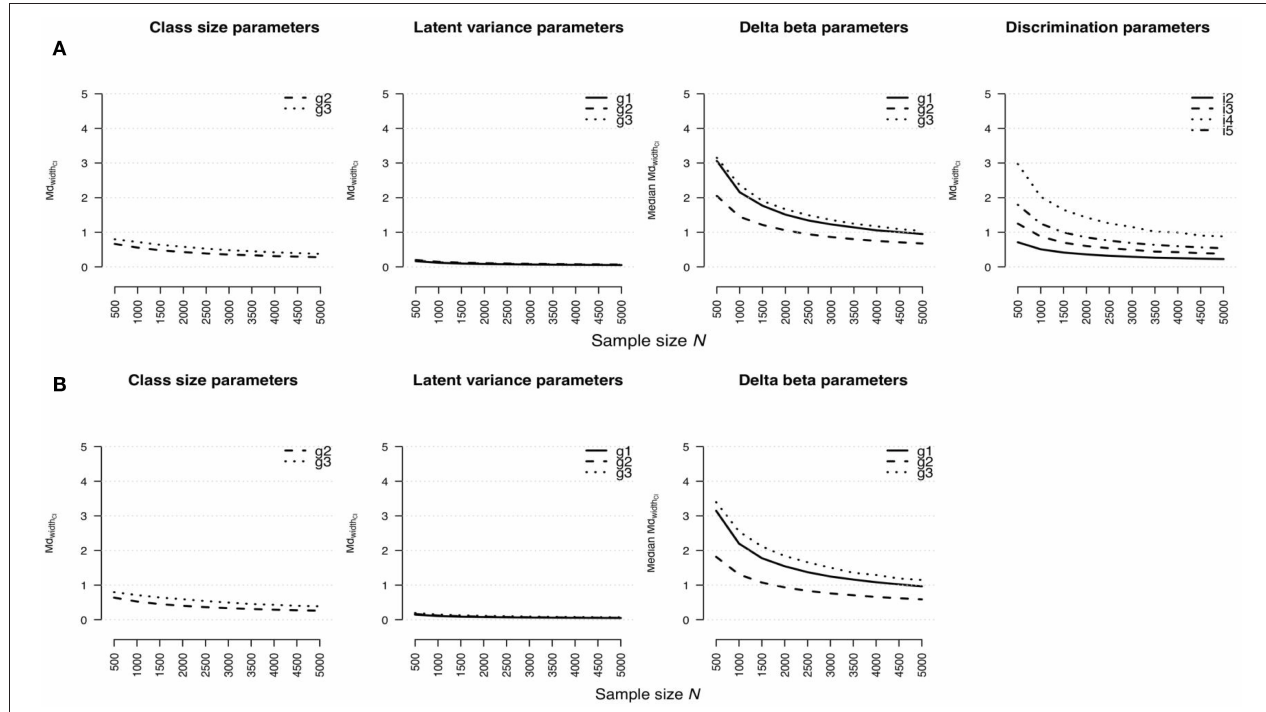
FIGURE 3 | Width of confidence interval for parameter estimates in (A) the rmGPCM-3 and (B) the mPCM-3 under the condition of a three-class mixture and a 5-item scale with 11 categories.